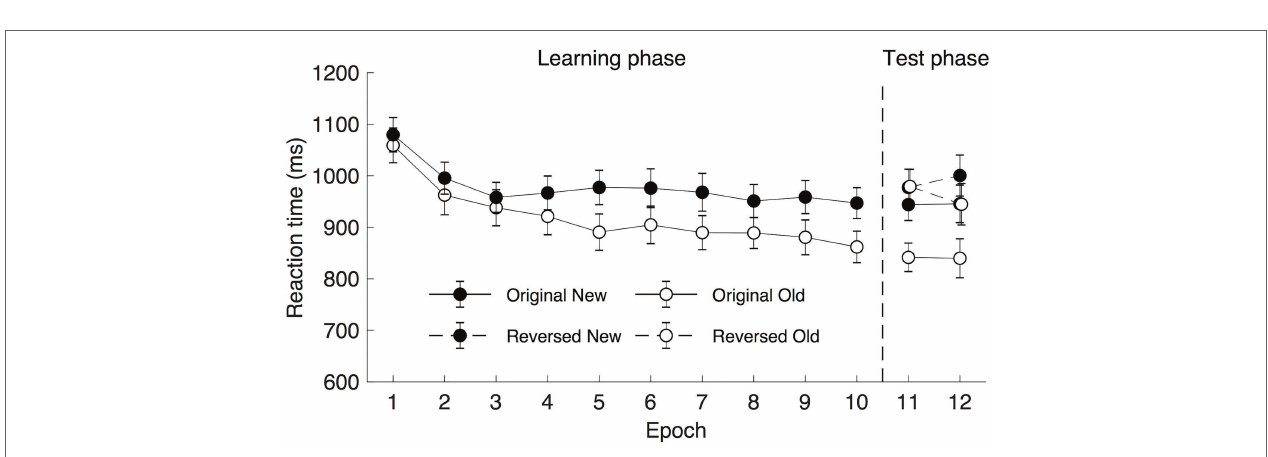
FIGURE 5 | Mean RT as a function of epoch and context for long display presentation (2,500 ms). The error bars represent the within-subject SE of the mean. The black circle lines indicate the new context and the open circle lines indicate the old context. The solid line indicates the original context and the dashed line represents the reversed context, respectively.